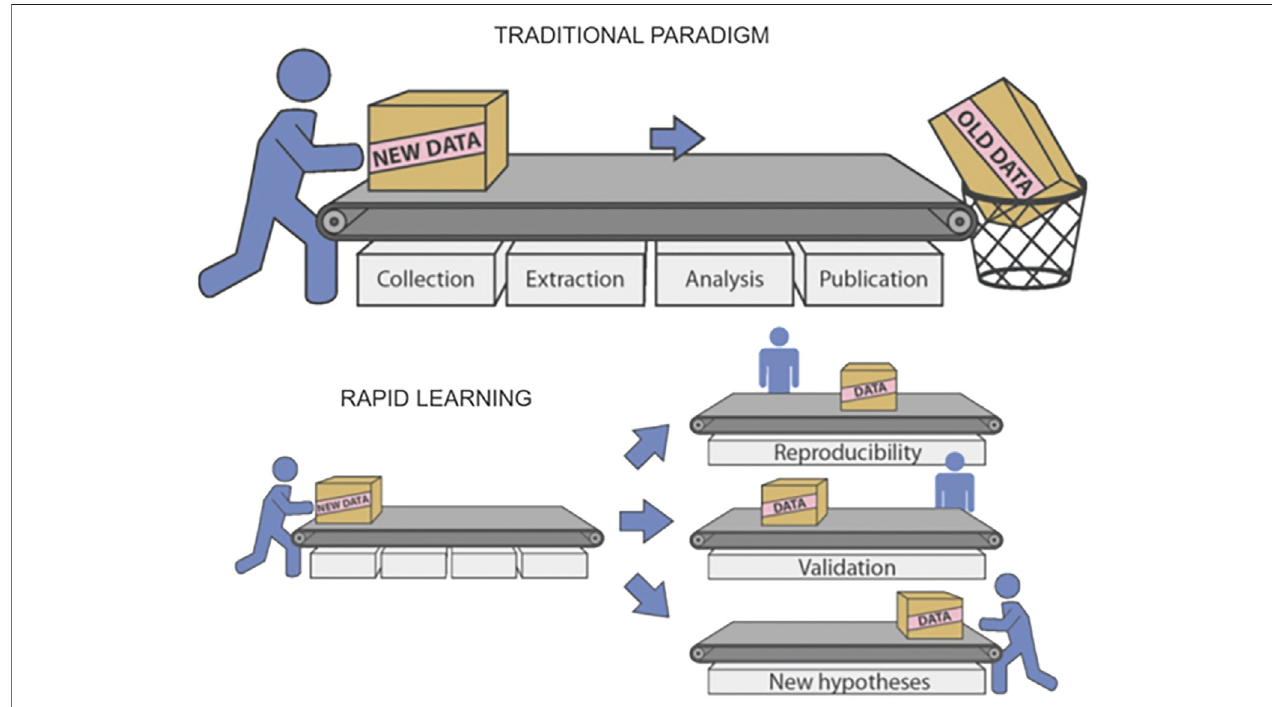
FIGURE 4 | Multiple reusability of data and results in Rapid Learning (courtesy of P. Lambin et al., 2015).